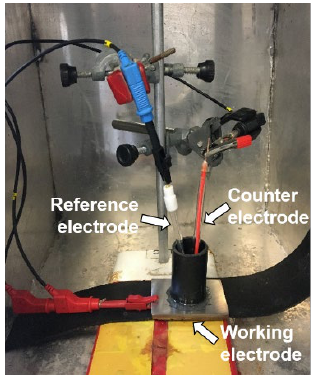
Figure 2. Experimental setup of the electrochemical cell.